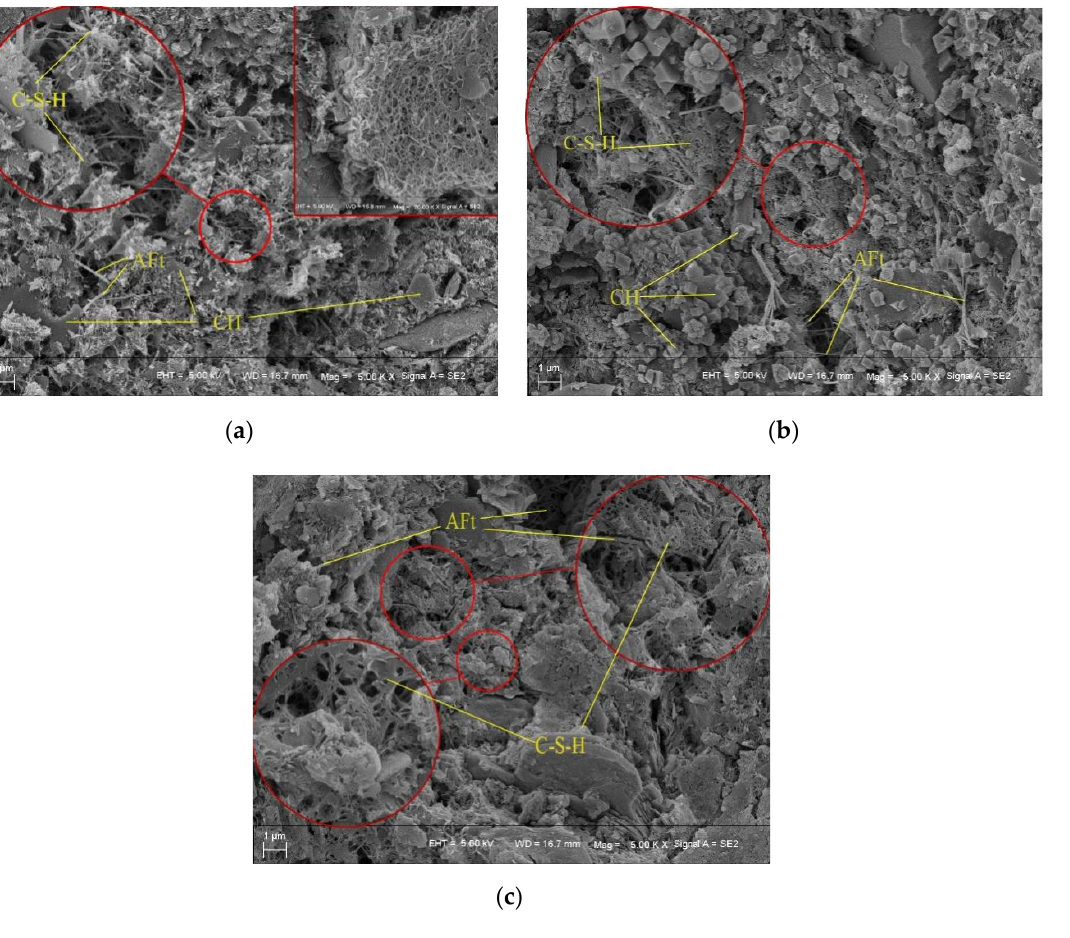
Figure 15. Microscopic images for specimens with 30% binder: ( a ) 30% cement ; ( b ) C/CFB = 5; ( c ) C/CFB = 2.